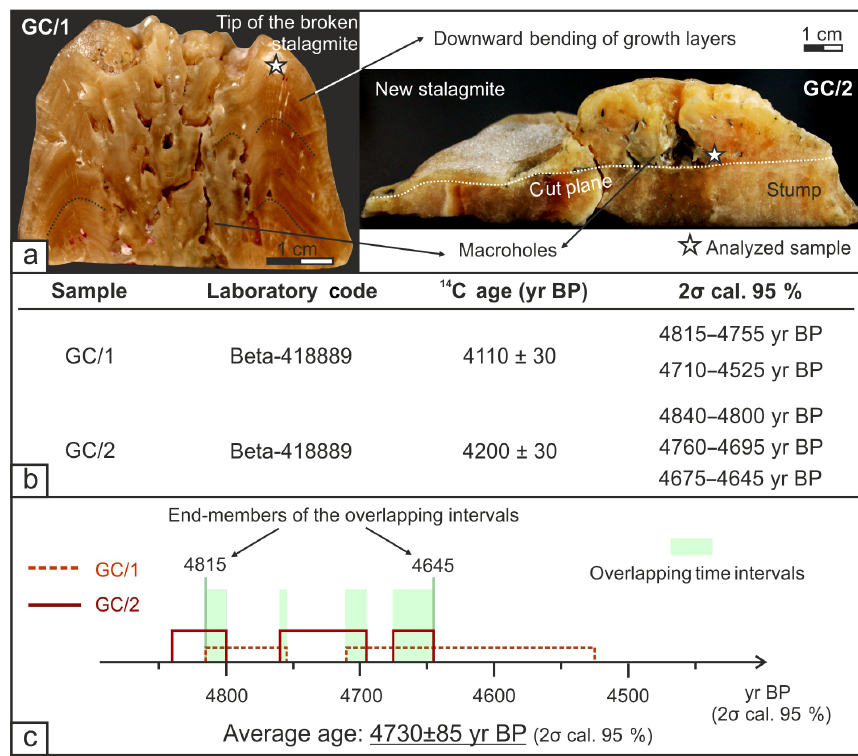
Figure 6. (a) Images of the analyzed samples GC/1 (tip of the broken stalagmite, likely pre-seismic) and GC/2 (new stalagmite growing on the stump, likely post-seismic); see sample locations in Fig. 5b. The axial section of the two samples shows a characteristic internal porous structure due to the presence of widespread syn-genetic “macroholes” (Shtober-Zisu et al., 2012), which are also responsible for the downward bending of the growth layers (marked with dotted lines in a ). White stars indicate the points where material was collected for radiocarbon dating. (b) Results of the dating performed on the two samples through AMS analysis (by Beta Analytic Radiocarbon Dating Laboratory, Florida, USA). (c) Overlapping time intervals that allow for restricting the time span within which the rupture of the speleothem occurred (4730 ±